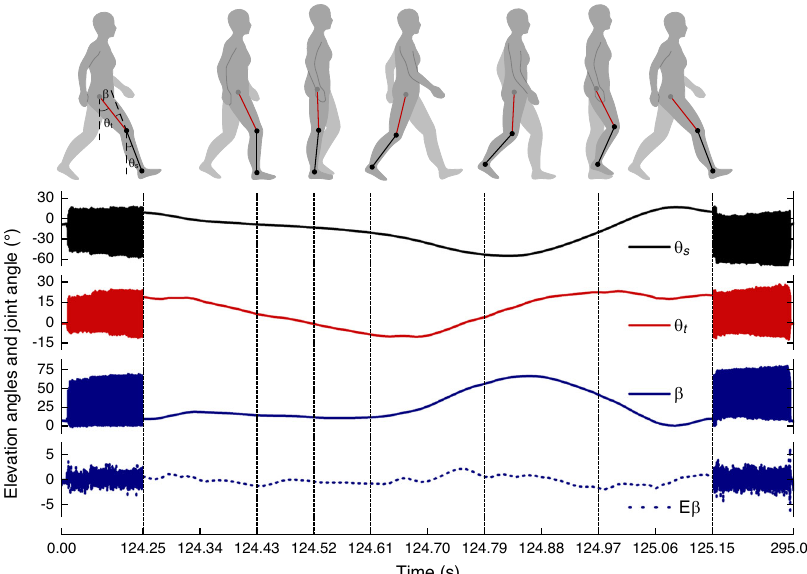
Fig. 7 Results of lower limb motion capture in the sagittal plane by using single device worn on the shank and determining the thigh motion from the shank motion by the trained neural network model of intra-limb coordination. The pitch angles of thigh θ t and shank θ s are used to represent the corresponding elevation angles in the sagittal plane, respectively. The joint angle of knee β in the sagittal plane is derived by subtracting θ s from θ t . The error of β (E β ) represents the estimation performance of both θ t and β , including the measurement error of the wearable device and the model error of the neural